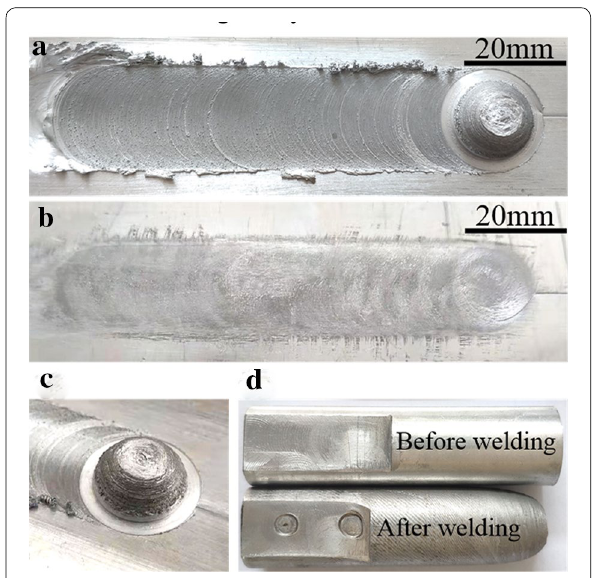
Figure 3 Morphology of the weld: a top surface of the weld; b bottom surface of the weld; c end of the weld; d stir bar before and after welding